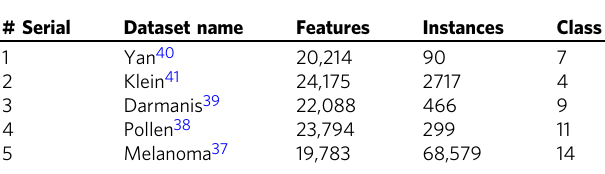
Methods Overview of datasets . We have used fi ve public benchmark scRNA-seq datasets: Melanoma 37 , Pollen 38 , Darmanis 39 , Yan 40 , and Klein 41 downloaded from Gene